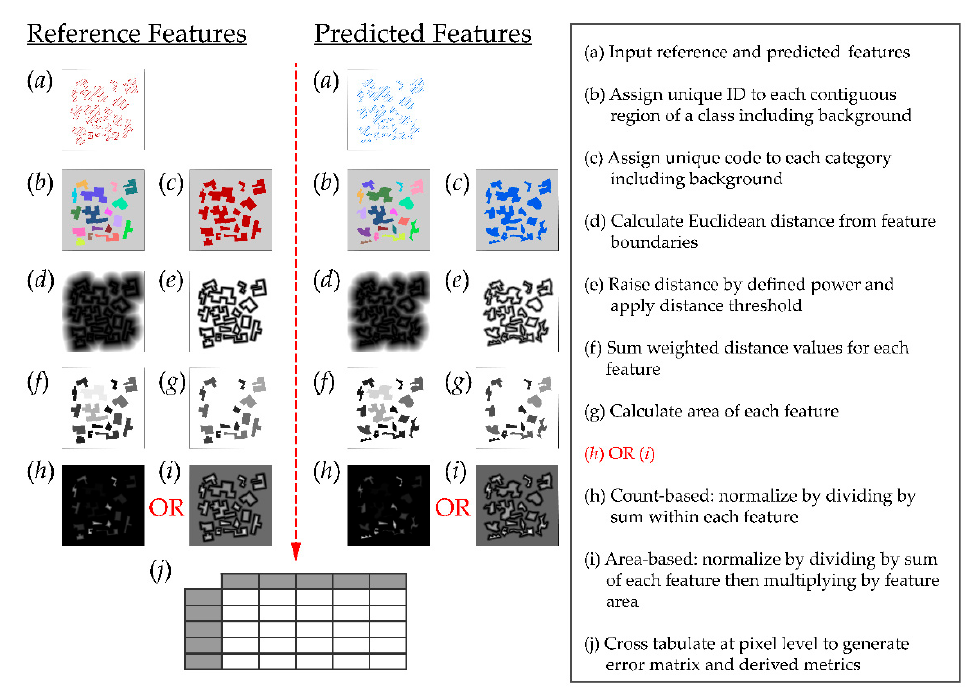
Figure 3. Conceptualization of feature center-weighted accuracy assessment method. Step ( h ) is performed to normalize by feature count. If area-based calculations are preferred, then step ( i ) is implemented instead of ( h ).